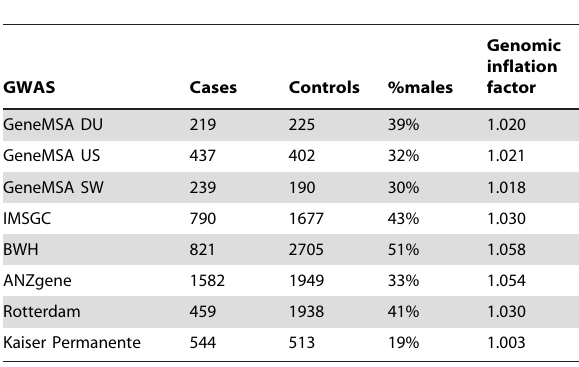
Table 1. Descriptive characteristic of analyzed data